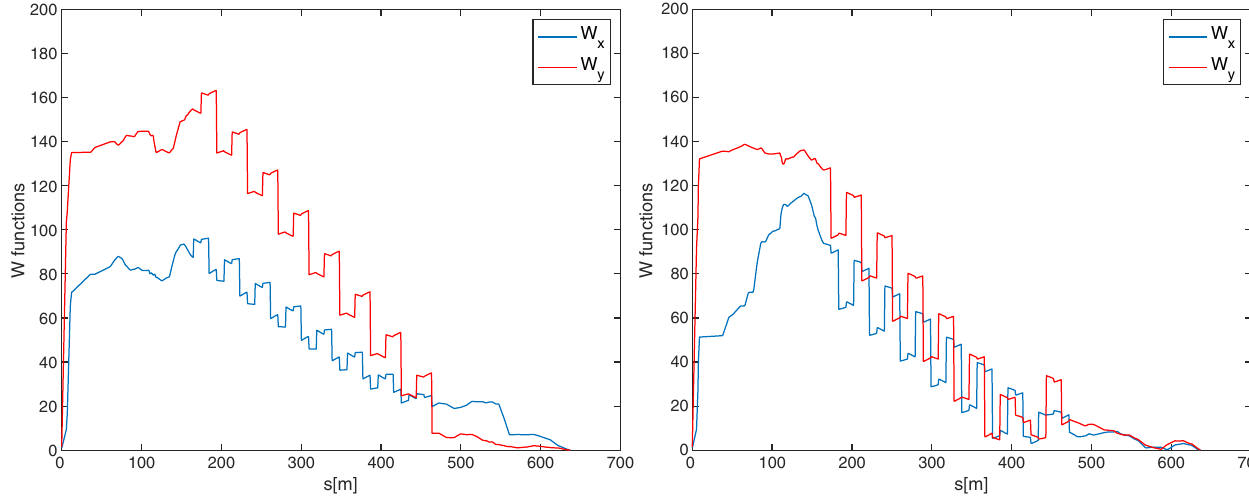
FIG. 6. Amplitudes of the W functions in the upstream of the IR6 (left) and the downstream of the IR8 (right) using four families of sextupoles in the adjacent arcs, where IP is at s ¼ 0